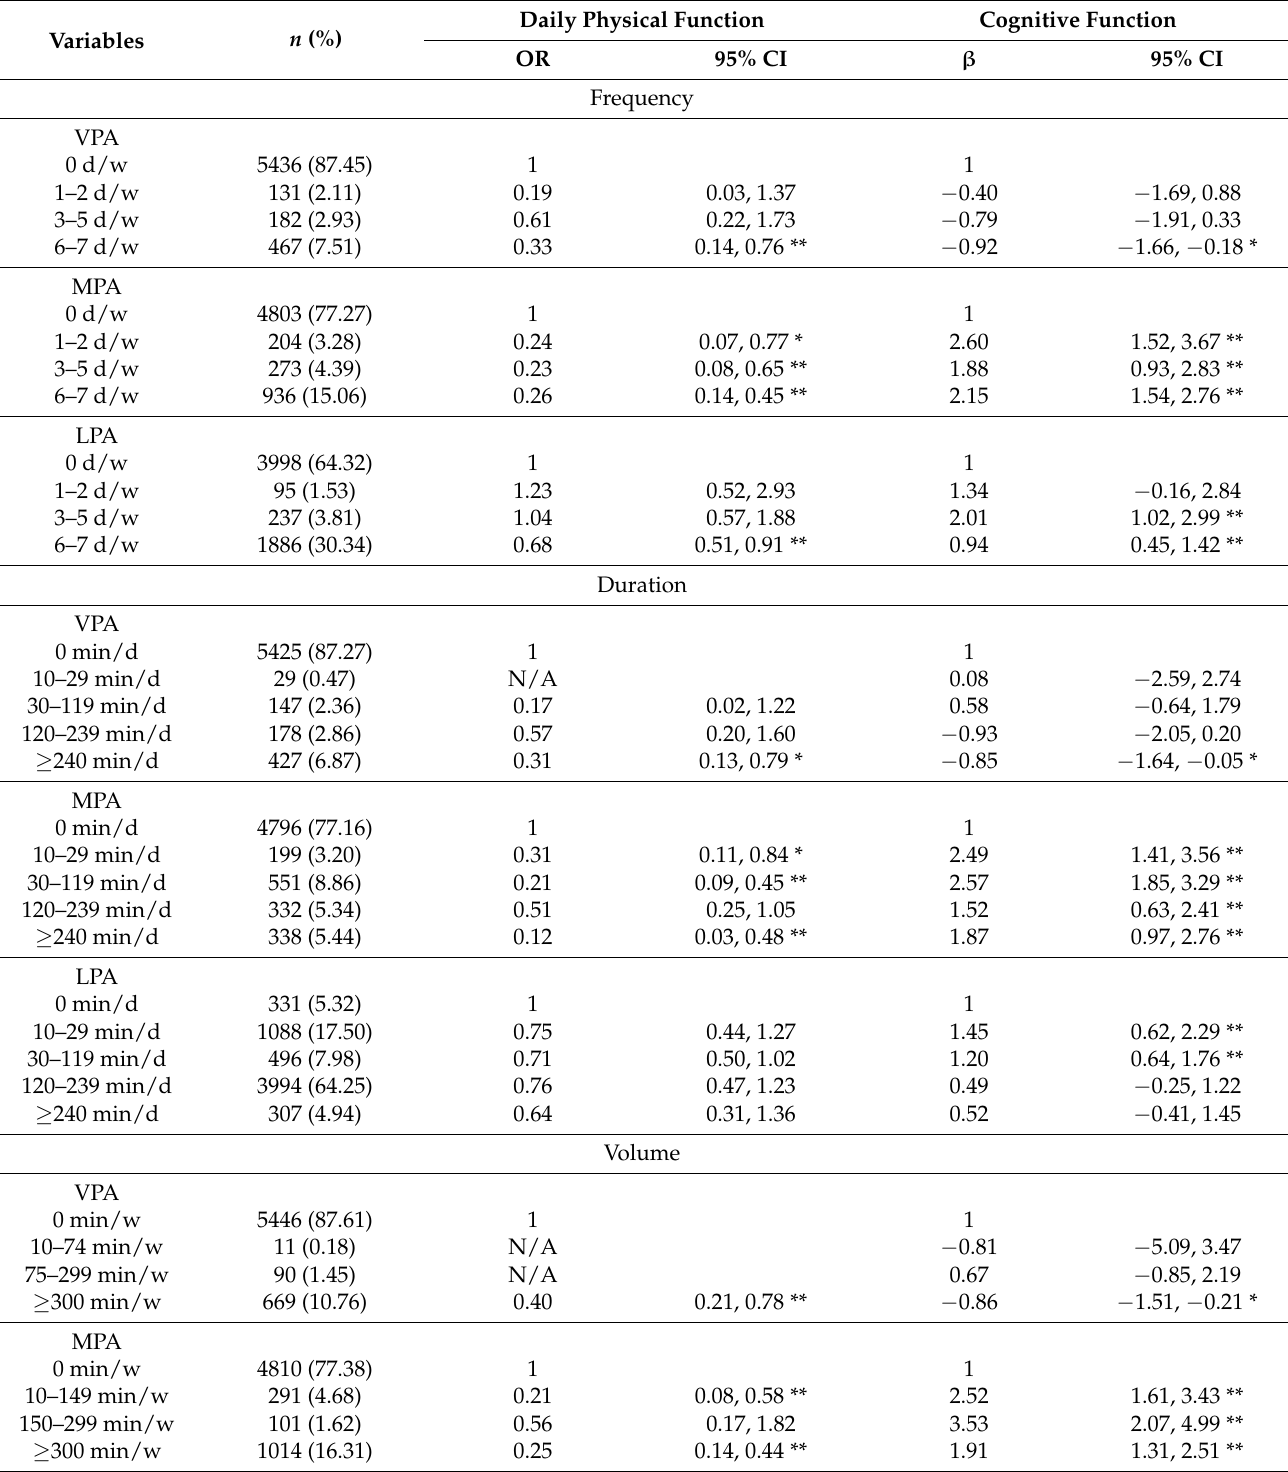
Table 2. Associations between PA and DPF and CF of patients with